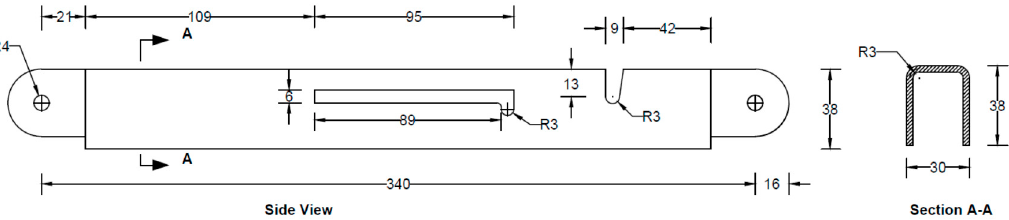
Figure 8. Details of primary folding link bars (all dimensions are in mm, steel plate gauge 11).